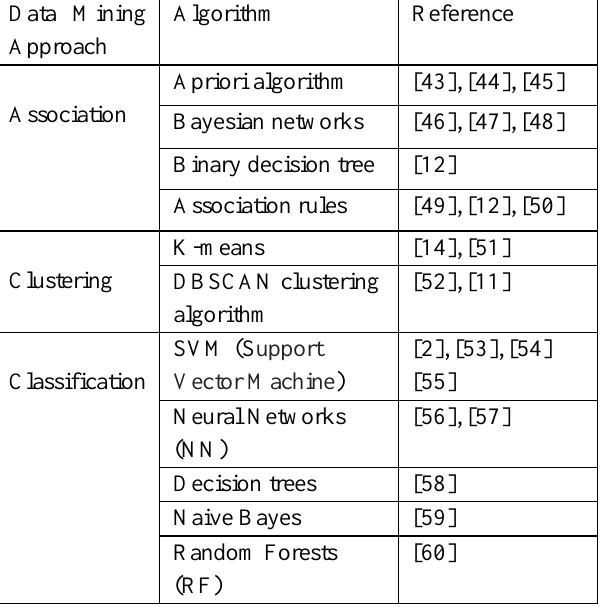
Table 1: Summary of literature on data mining algorithm used on GPS